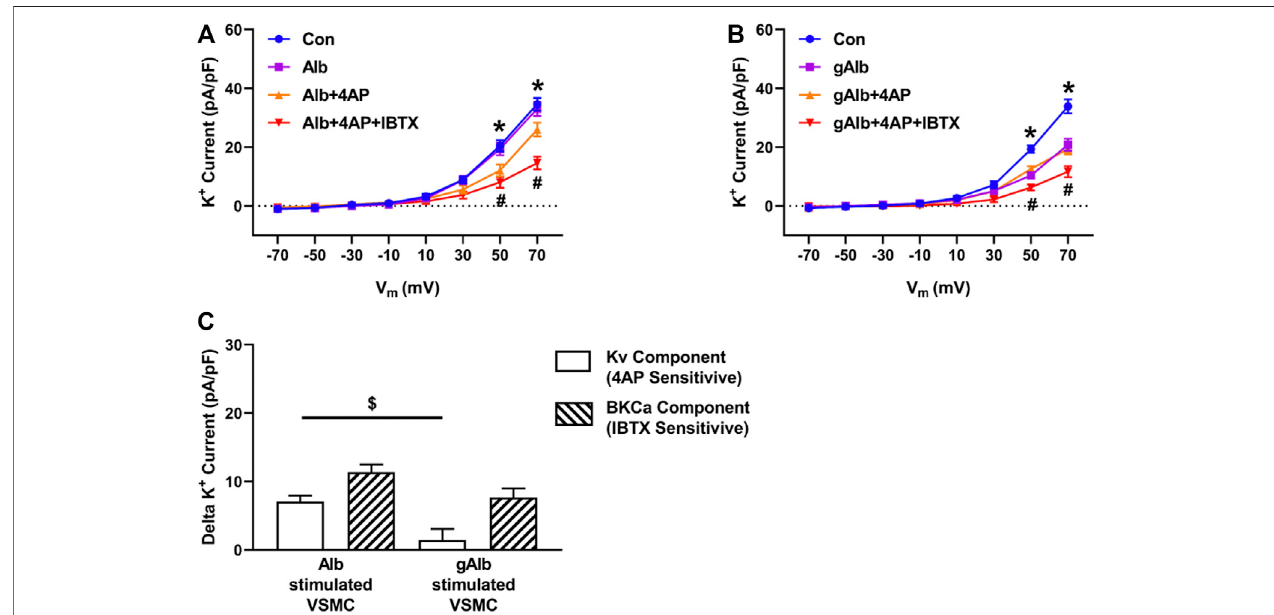
FIGURE3| Effects ofAlbandgAlbonmajorcomponentsofwholecellK + current.Panel (A,B) EffectofAlb( n =8)andgAlb(15 μ g/ml; n =7),respectivelyonwhole cell K + currents under control conditions and in the presence of selective K + channel inhibitors. Components of the total K + current were isolated by 4-AP (0.1 mM) to inhibit Kv and IBTX (0.1 μ M) to block BK Ca . * p < 0.05, Control vs. Alb+4AP or gAlb+4AP; # all groups vs. Alb+4AP + IBTX or gAlb+4AP + IBTX. Panel (C) illustrates that gAlb inhibits both the K V and BK Ca components of whole cell K + current, calculated as 4-AP and IBTX sensitive currents from panels (A,B) by subtracting current amplitudes in the presence of either Alb or gAlb currents from those observed following bath addition of 4-AP (0.1 mM) and IBTX (0.1 μ M). Bar graphs are presented as mean ± SEM for data at +70 mV * p < 0.05.